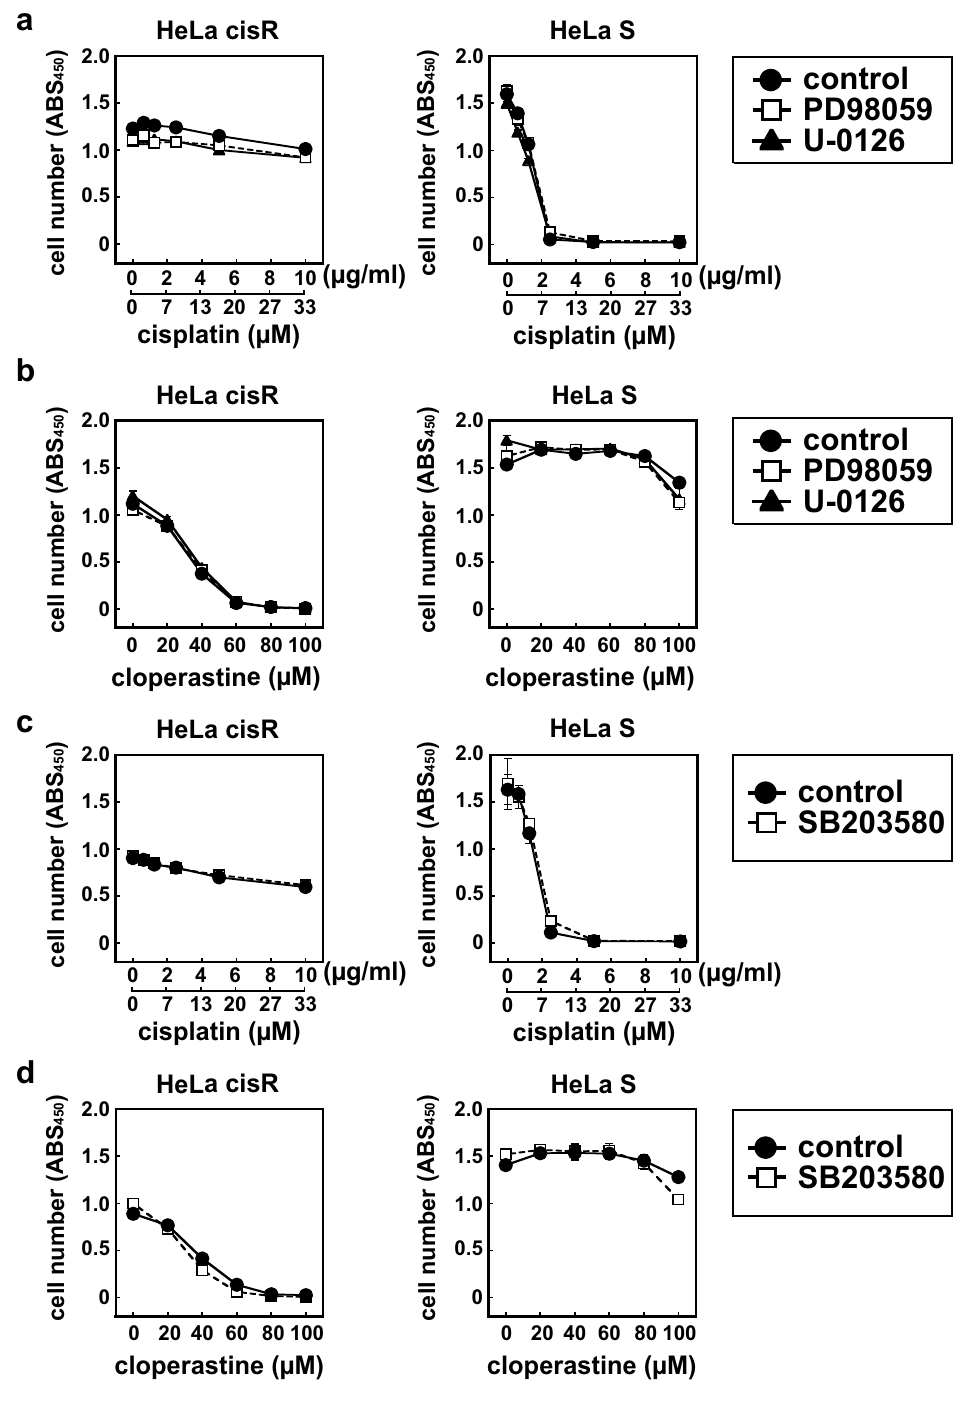
Figure 8. MEK and p38 MAPK signal transduction pathways are not involved in the cloperastine cytotoxicity toward HeLa cisR cells. ( a , b ) Effects of inhibitors of MEK on the cytotoxicity of cisplatin ( a ) and cloperastine ( b ) toward HeLa cisR and HeLa S cells. Filled circles, control; open squares, PD98059; filled triangles, U-0126. c and d , Effects of an inhibitor of p38 MAPK on the cytotoxicity of cisplatin ( c ) and cloperastine ( d ). Filled circles, control; open squares, SB203580. The results are presented as means ± S.D. of triplicate (a and b) or quadruplicate (c and d) samples. Three separate experiments yielded essentially the same